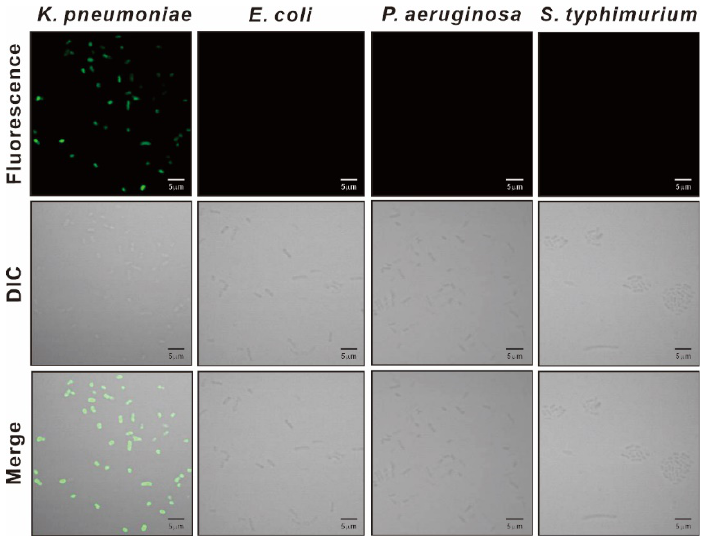
Figure 4. Confocal laser scanning microscopy of bacteria treated with KP peptide. Bacterial cells were incubated with the biotinylated KP peptide and visualized with Alexa 488-labeled streptavidin.